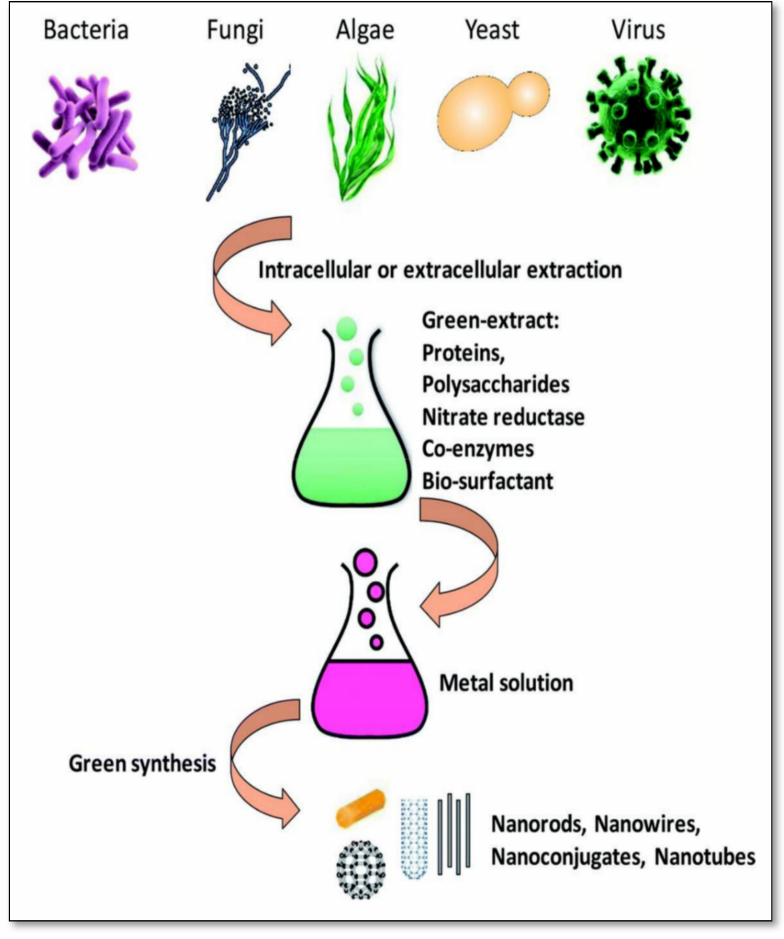
Figure 2. Biological approach to nanoparticle synthesis